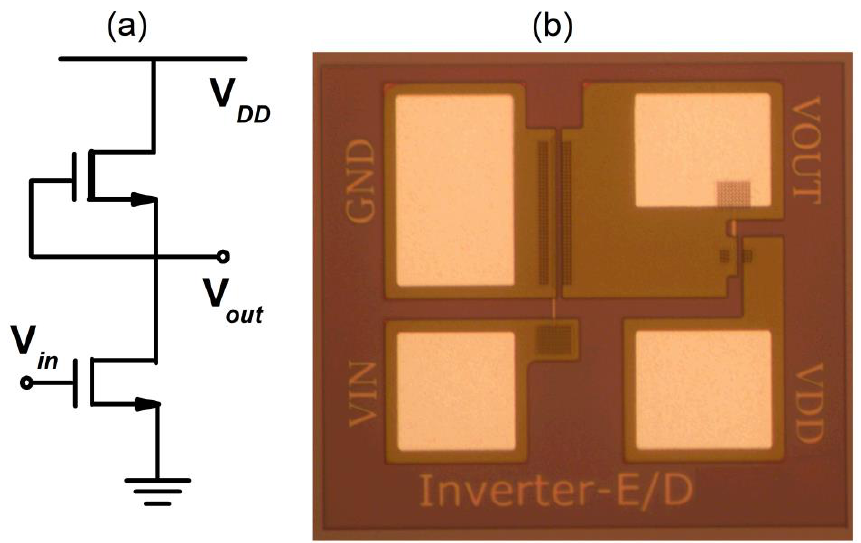
Figure 1. ( a ) A typical circuit schematic of the E/D-mode GaN inverter and ( b ) top view of the fabricated E/D-mode inverter.